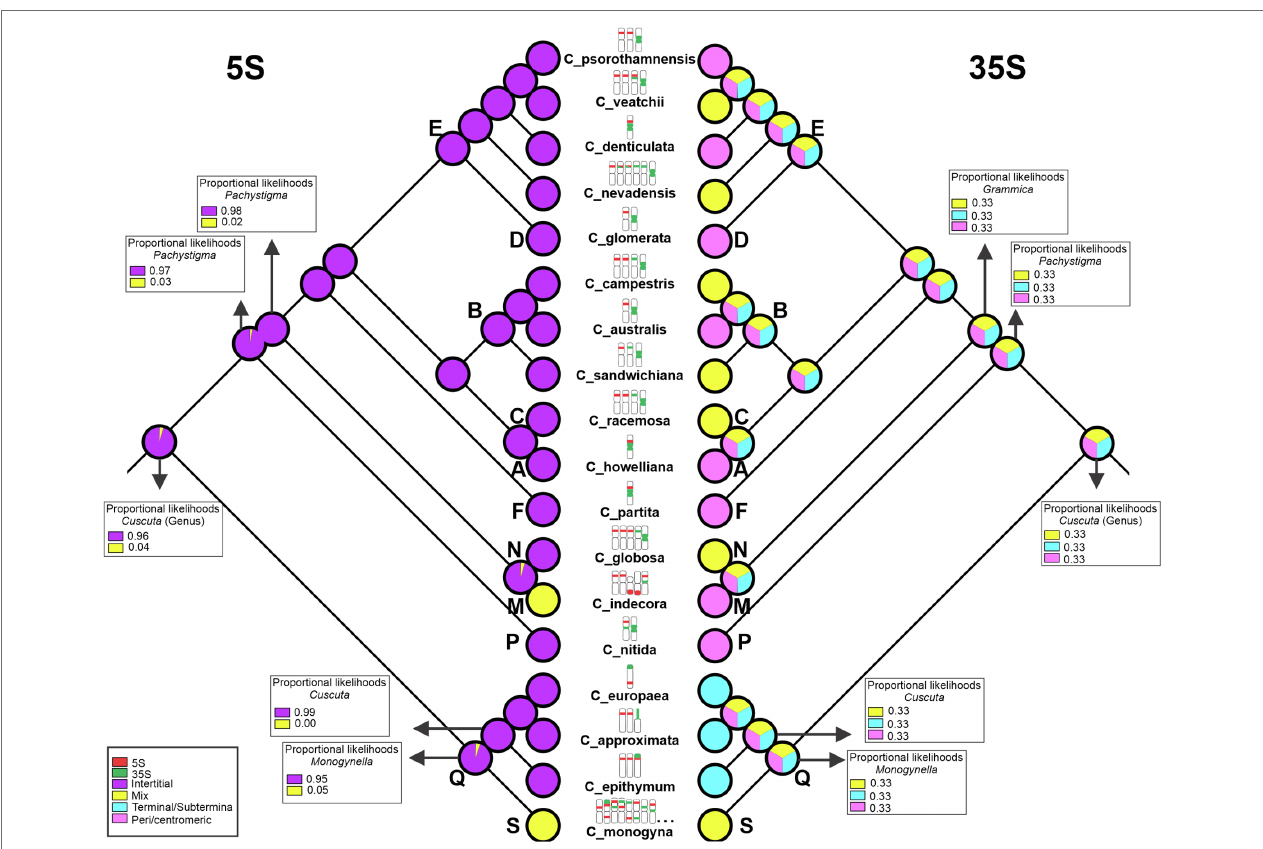
FIGURE 6 | Reconstruction of the position of the 5S (left) and 35S (right) rDNA sites. In subgenus Monogynella, there is an increase in the diversity of positions in which the rDNA sites were found, suggesting that the “mix” condition is derived. In C. monogyna, not all pairs are represented because it is a species that has more than 30 rDNA sites, but all observed patterns are outlined. The bold letters represent the sections described by García et al. (2014): section S (subgenus Monogynella ), sections R and Q (subgenus Cuscuta ), section P (subgenus Pachystigma ), and sections A–O (subgenus Grammica